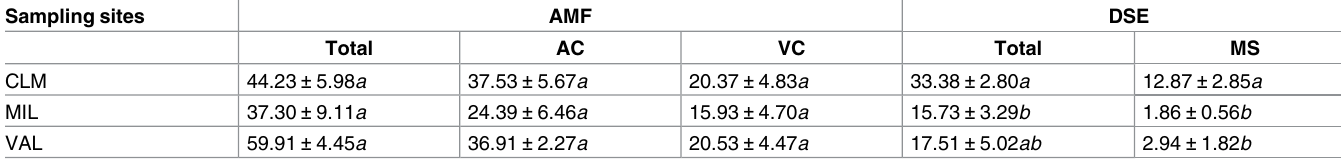
Table 2. Percentage of Fungal Colonization of the B . subacaulis Roots. The mean values ± SE of five root apparatusreplicates are given as percent- ages of the root length. Sampling